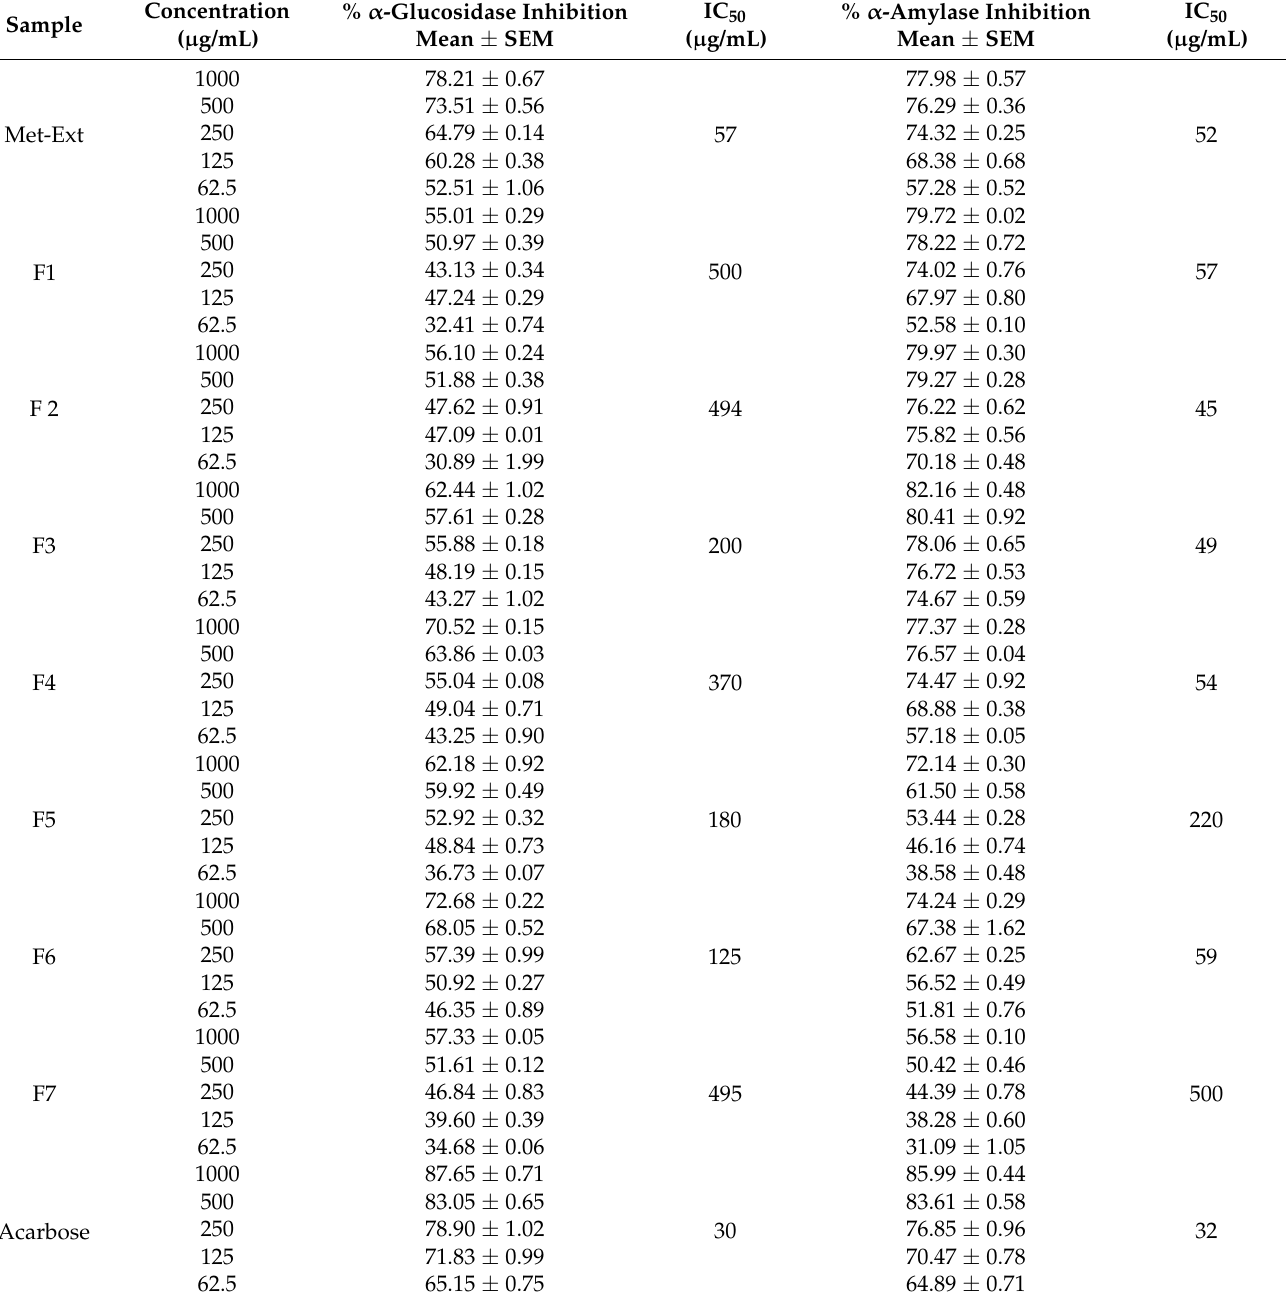
Table 6. α -Glucosidase and α -amylase inhibitions of Cydonia oblonga of methanolic extract and subsequent purified fractions at different